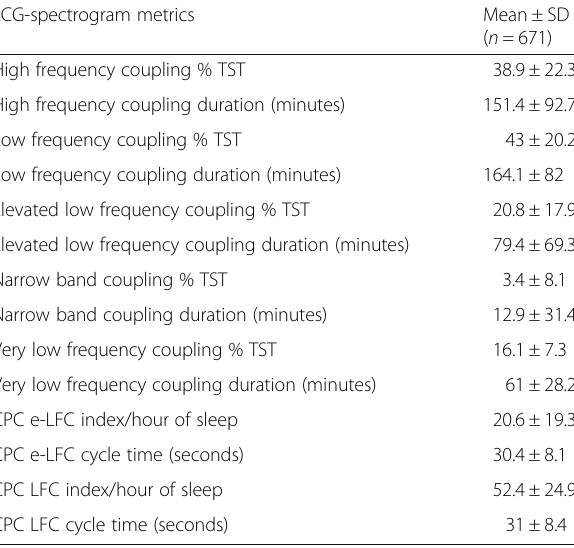
Table 3 ECG-spectrogram features in the